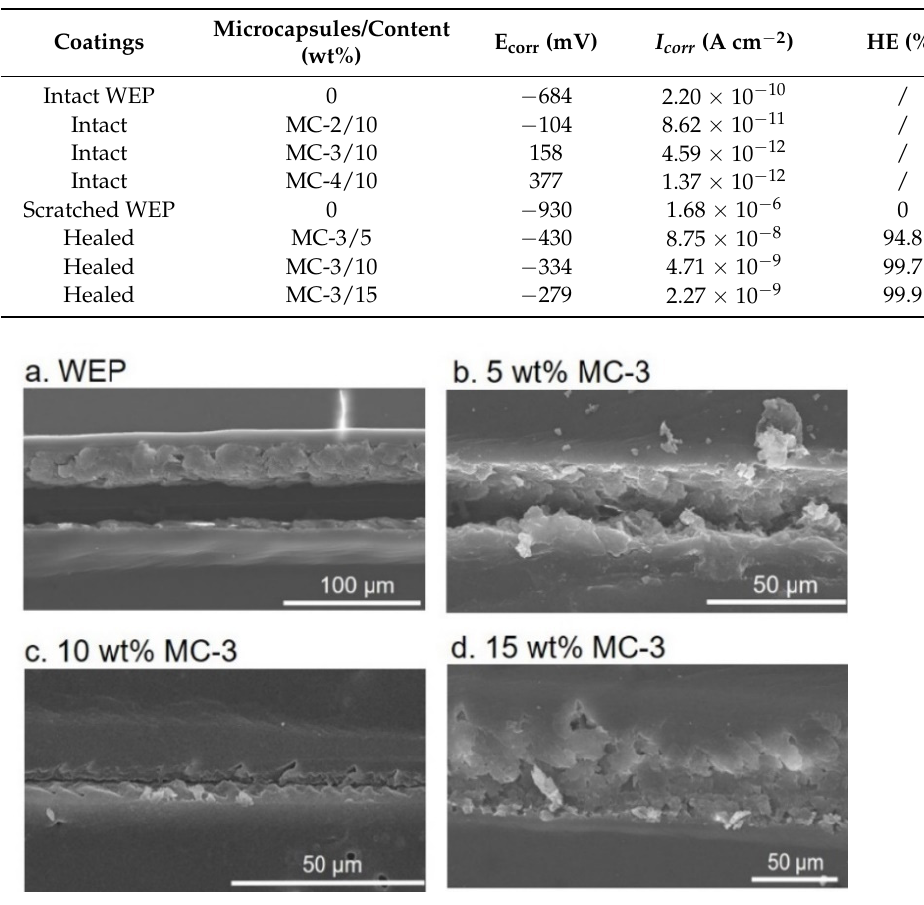
Figure 6. The morphology of the healed coatings containing ( a ) 0%, ( b ) 5 wt%, ( c ) 10 wt% and ( d ) 15 wt% of MC-3. ( d ) 15 wt% of MC-3.